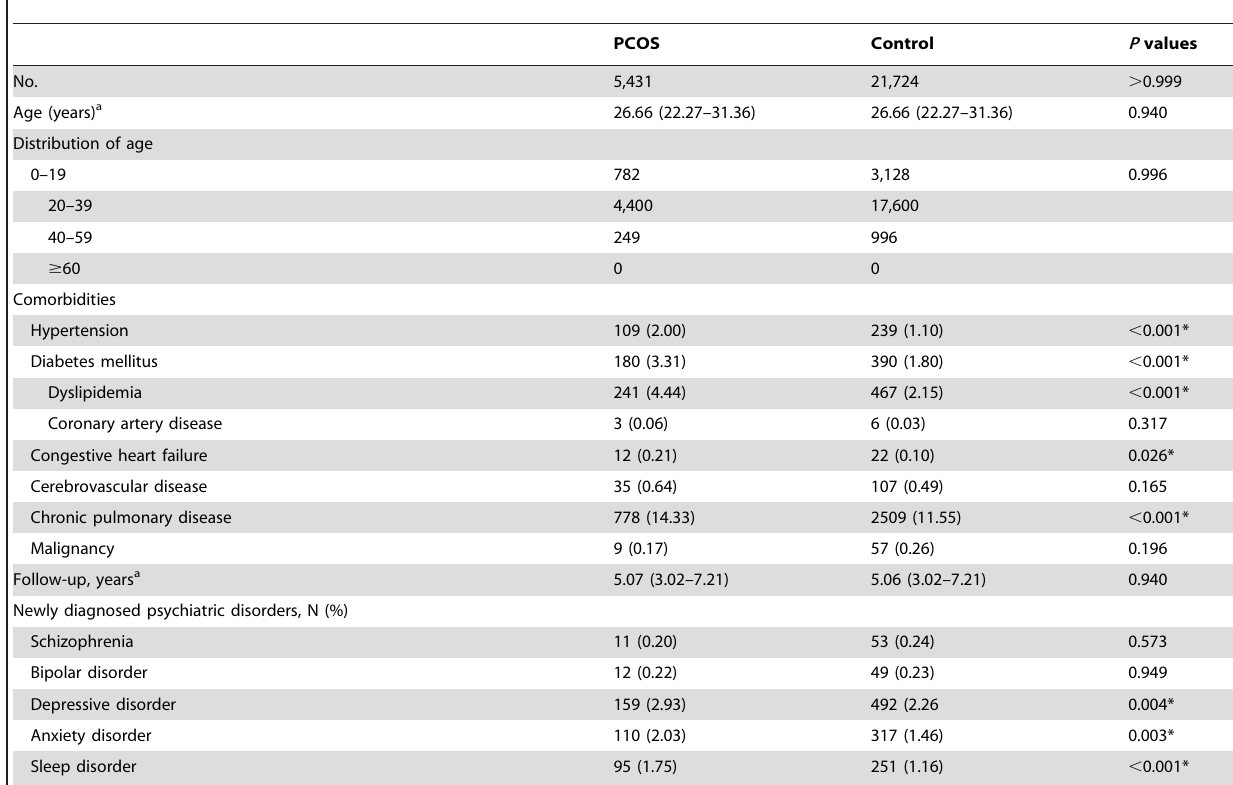
Table 1. Characteristics of patients with polycystic ovarian syndrome (PCOS) and control subjects.